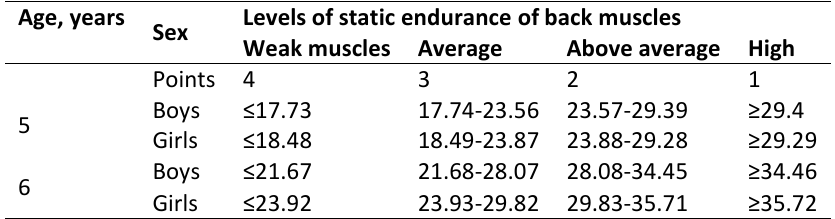
Table 1. Static endurance of back muscles (sec.)